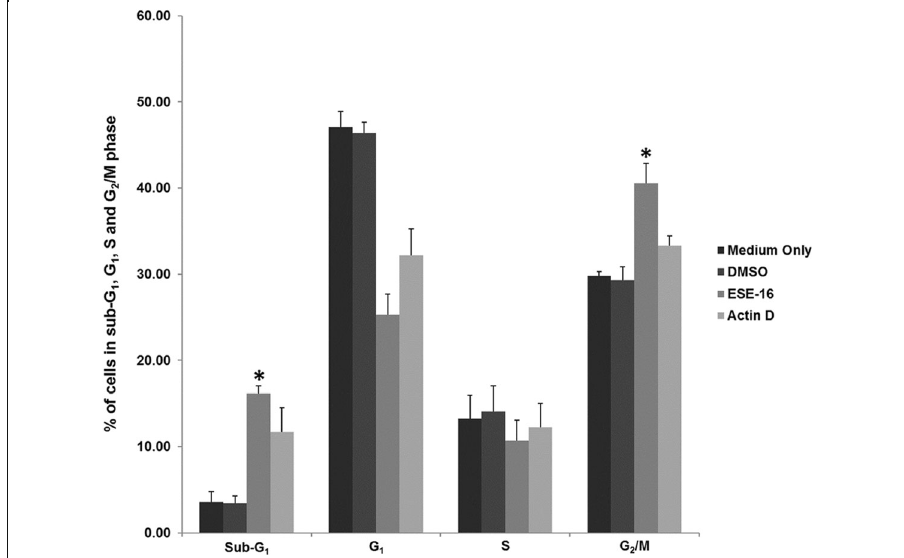
Fig. 9 Bar graph indicating the percentage of HeLa cells in the sub-G 1 , G 1 , S and G 2 /M phases. The data re- vealed a statistically significant increase in cells present in the sub-G 1 and G 2 /M phase after ESE-16 treat- ment when compared to controls. *p <